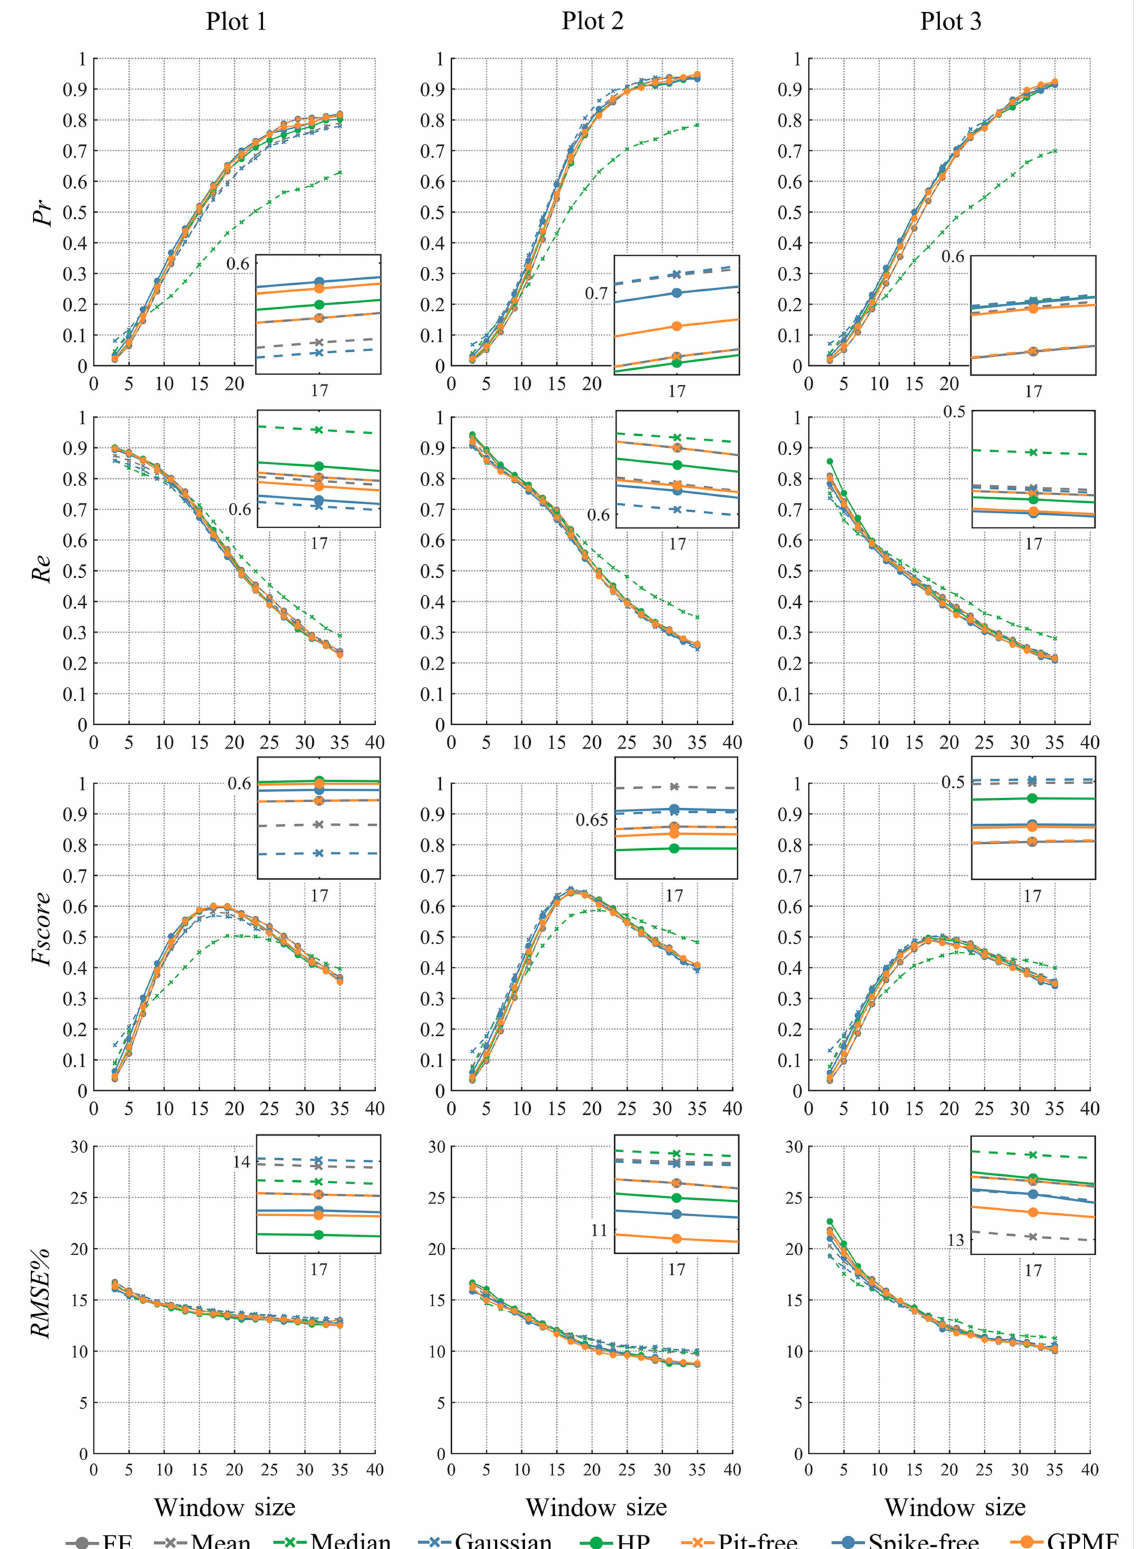
Figure 8. Accuracies of individual tree detections and tree height estimations using different window sizes (each cell size is 0.1 m) in the local maxima